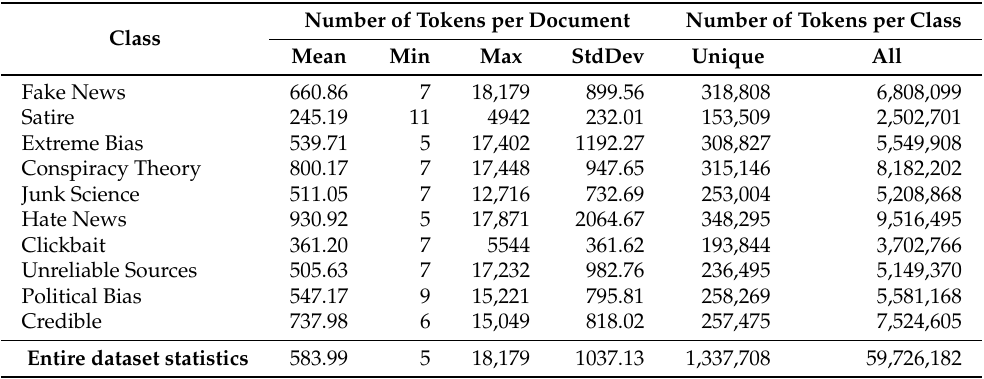
Table 2. Dataset description and